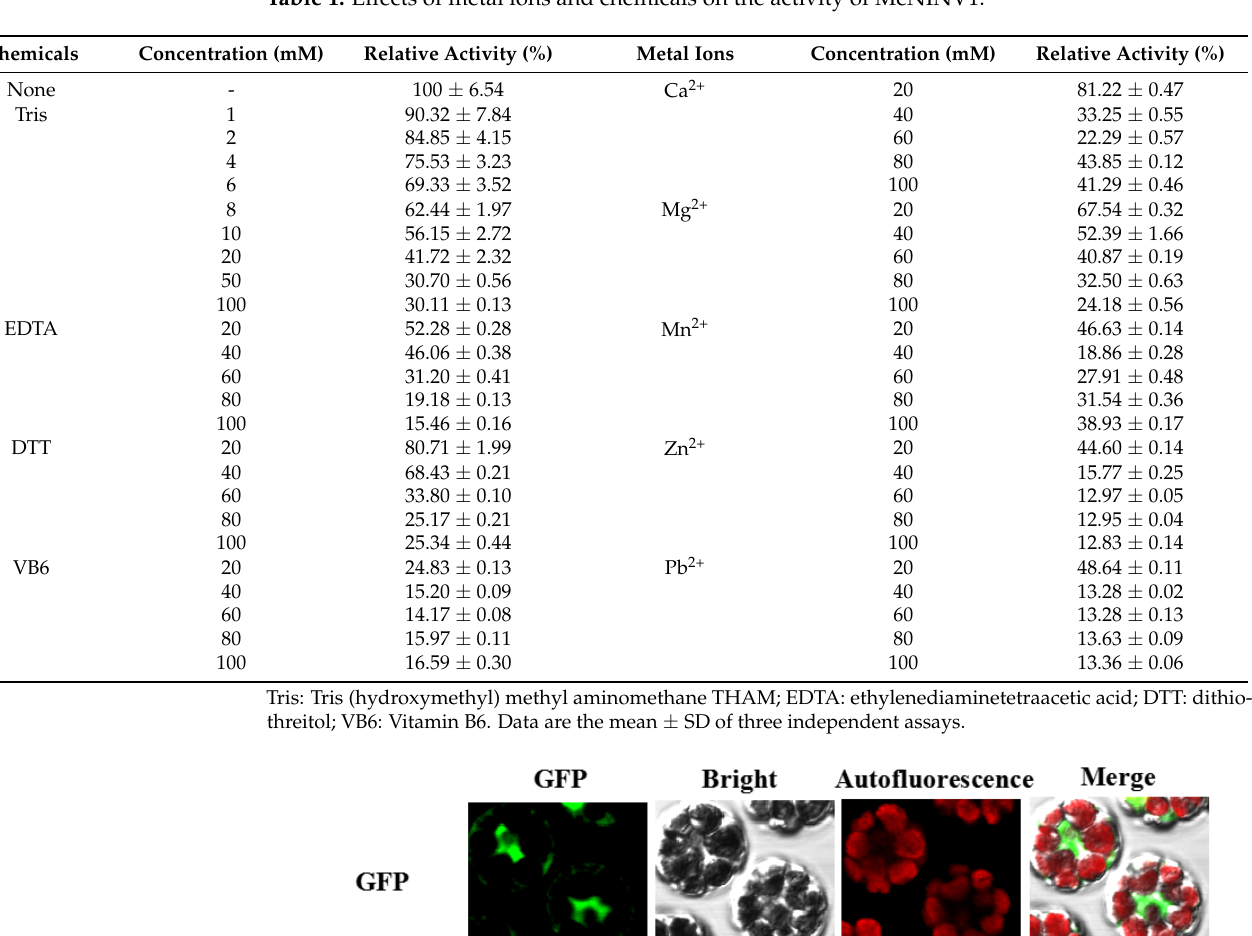
Table 1. Effects of metal ions and chemicals on the activity of MeNINV1.